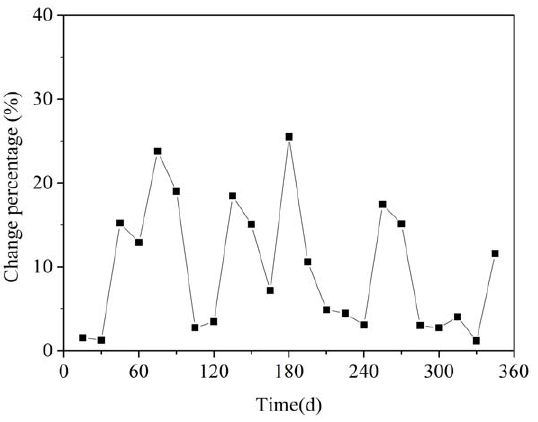
Figure 3. Moving-window analysis based on AOB T-RFLP profiles. Each data point is the change percentage between the bacterial communities of 2 consecutive dates. The time span between two consecutive dates is 15 days.